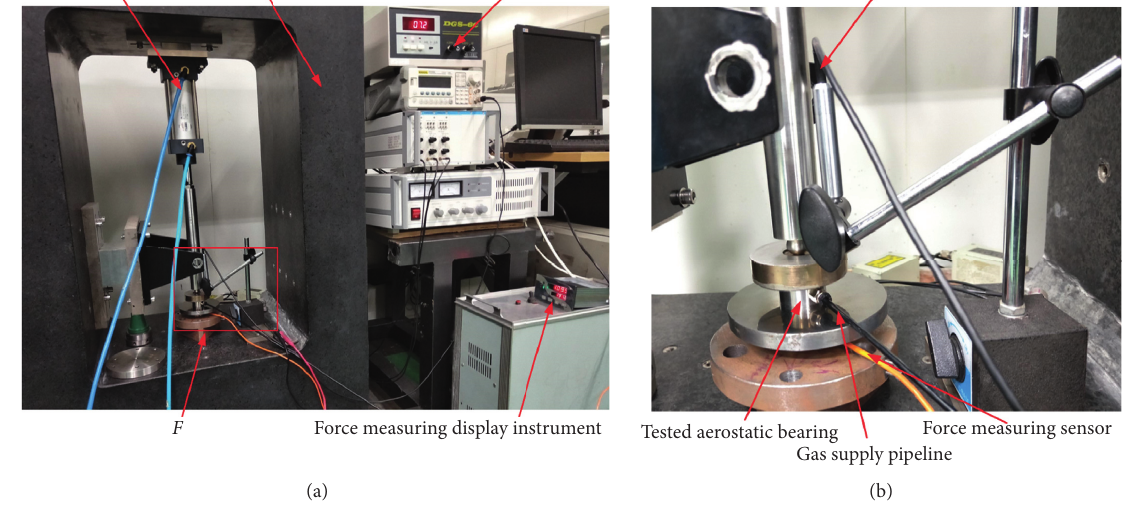
Figure 17: Diagram of the physical device for the test platform. (a) General drawing of the physical device; (b) partial enlarged drawing at F